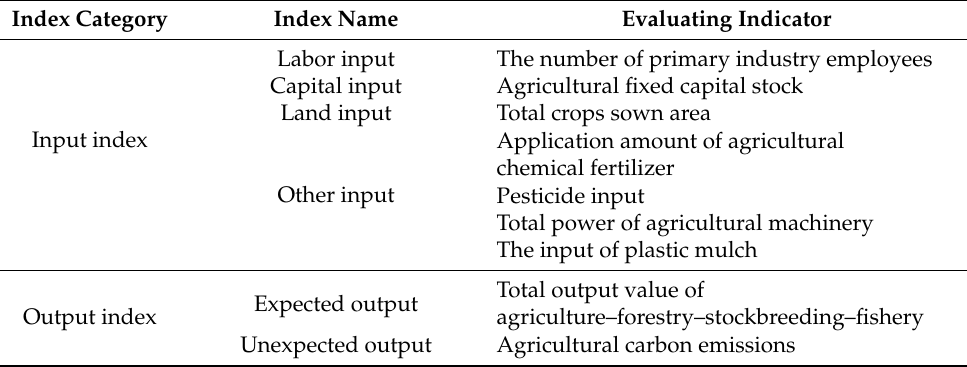
Table 1. ACP index